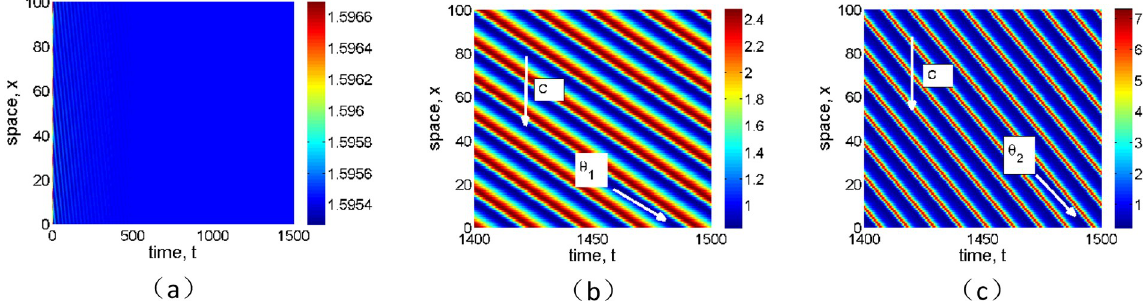
Fig 8. Effects of infiltration positive feedback coefficient α on the formation of spatial pattern for grass. The fixed parameter values p = 1, δ = 0.45, v = 9, and (a) α = 0, (b) α = 0.01 and (c) α = 0.2.